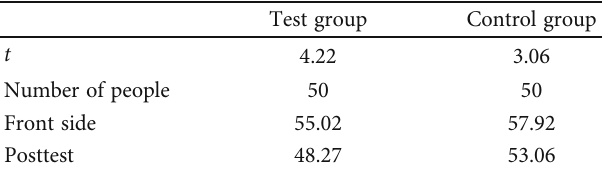
Table 3: Comparison of the results of the SDS self-rating depression scale between the experimental group and the control group before and after the